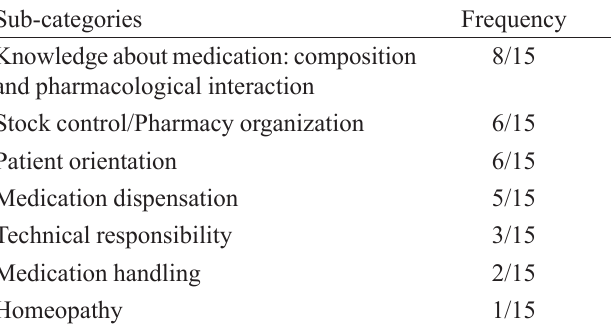
Table II synthesizes the more frequent responses. TABLE II - Frequency of responses related to works